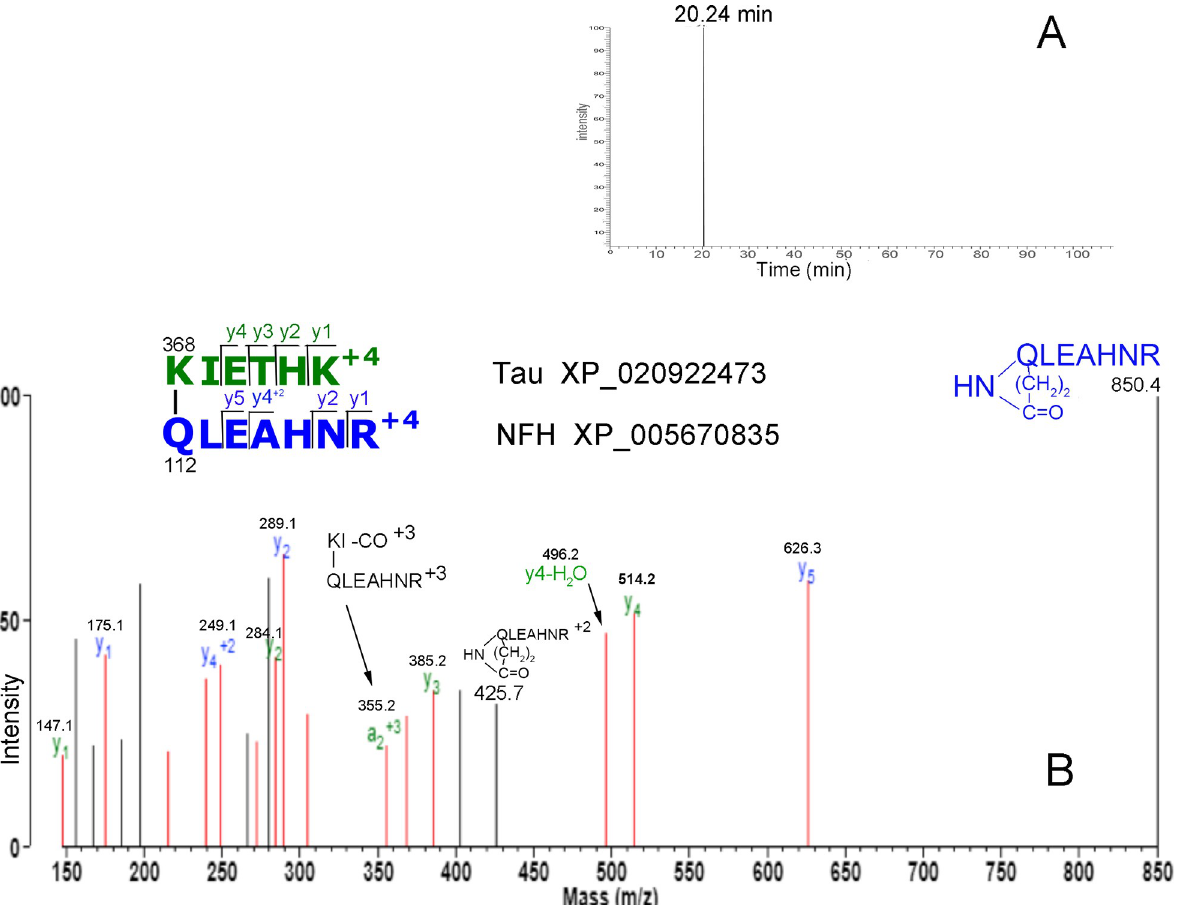
Fig 3. Immunopurified isopeptide from MAP-rich tubulin. Panel A shows that immunopurification on Dynabeads-Protein G-anti-isopeptide 81D1C2 yielded a single peptide eluting at 20.24 min. Panel B is the MS/MS spectrum of the immunopurified, naturally-occurring isopeptide in MAP- rich tubulin. The crosslink is between K368 of Tau and Q112 of NFH. The quadruply-charged parent ion is at 401.96